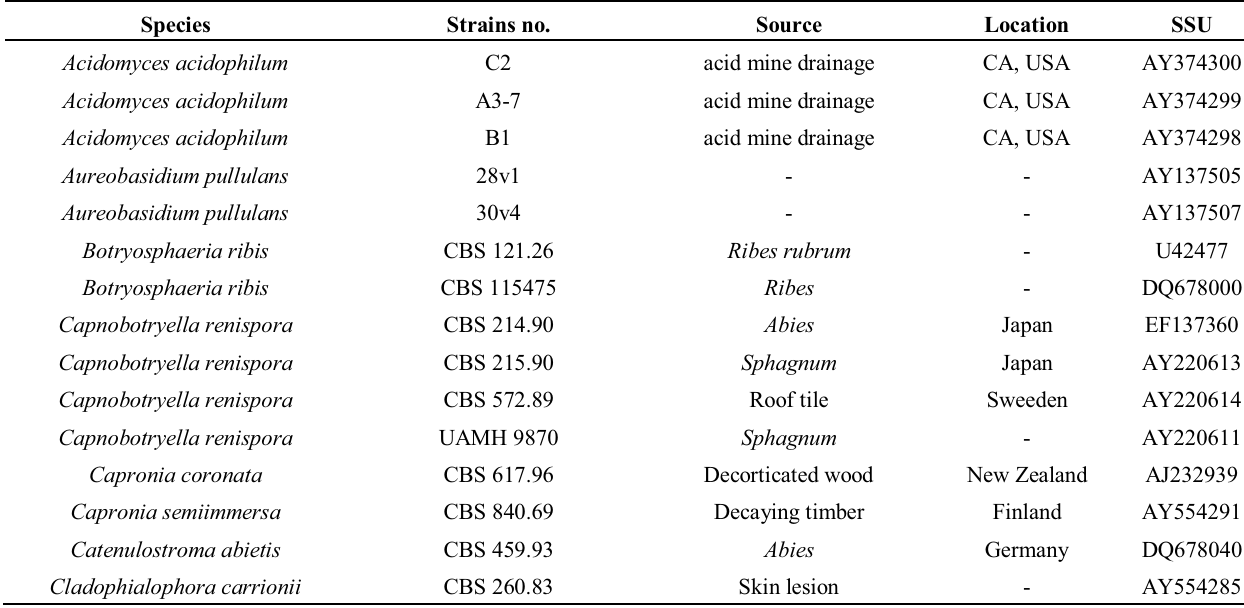
Table 2. List of strains and sequences